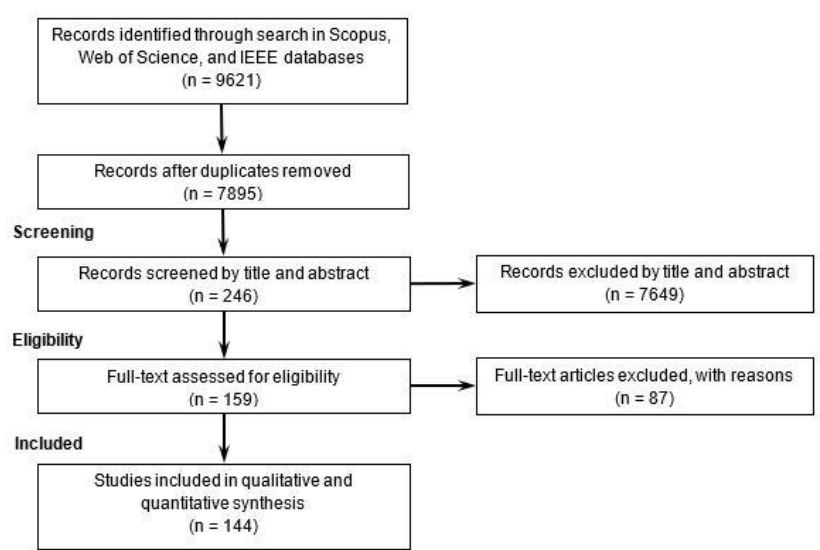
Figure 1. PRISMA statement flow diagram.